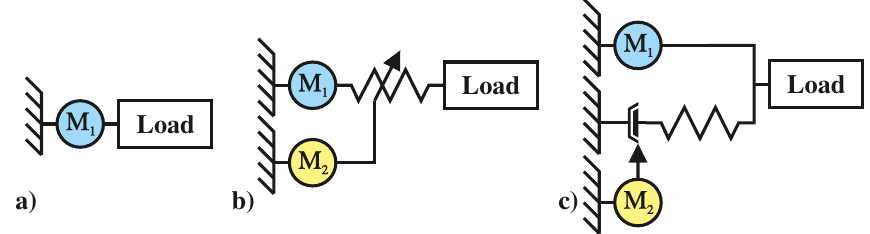
Figure 1. Three classes of actuators for hip and knee support: ( a ) Rigid actuator; ( b ) Variable stiffness serial elastic actuators (SEAs); ( c ) Clutched parallel elastic actuators